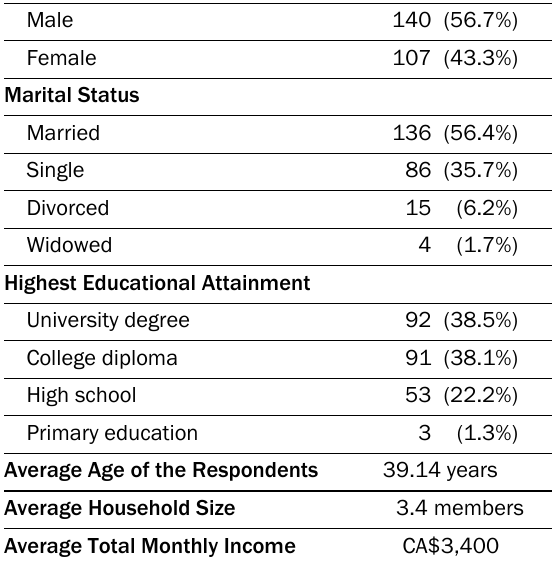
Table 2. Personal Characteristic of Respondents,